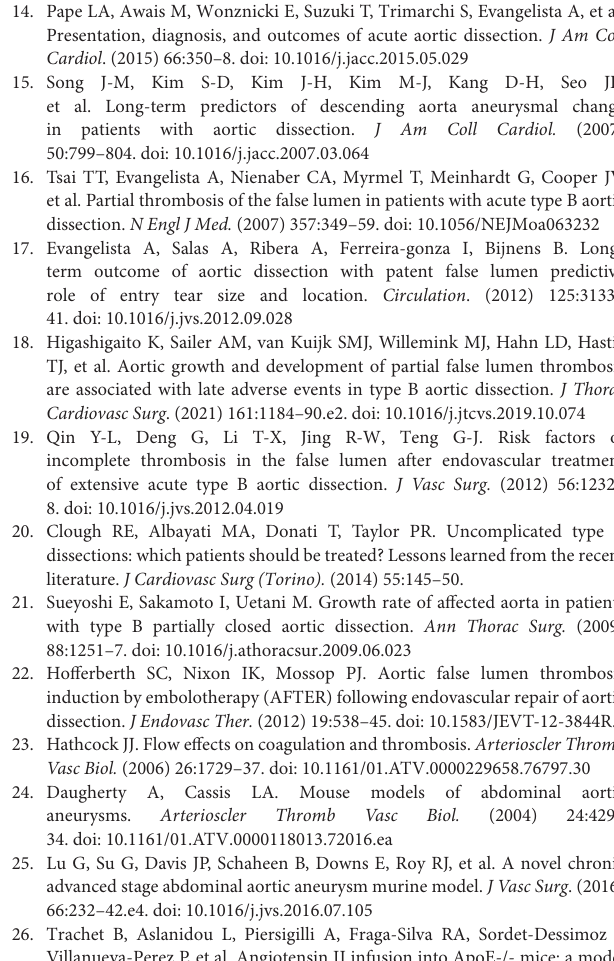
Supplementary Figure 3 | Upper row: Correlation between the patent false lumen (FL) length and the number of minor side branches originating from the FL at 3-, 24-, and 48-months follow-up for patients receiving thoracic endovascular repair (TEVAR). Spearman’s rank correlation was applied, and the corresponding p -value is displayed. Lower row: Forest-plot of standardized beta values for a multiple linear regression model of the axial length of the patent FL for the same time points. At 48 months follow-up, the model matrix was rank deficient and stent graft coverage was not estimable (also see Figure 5 for 12 months